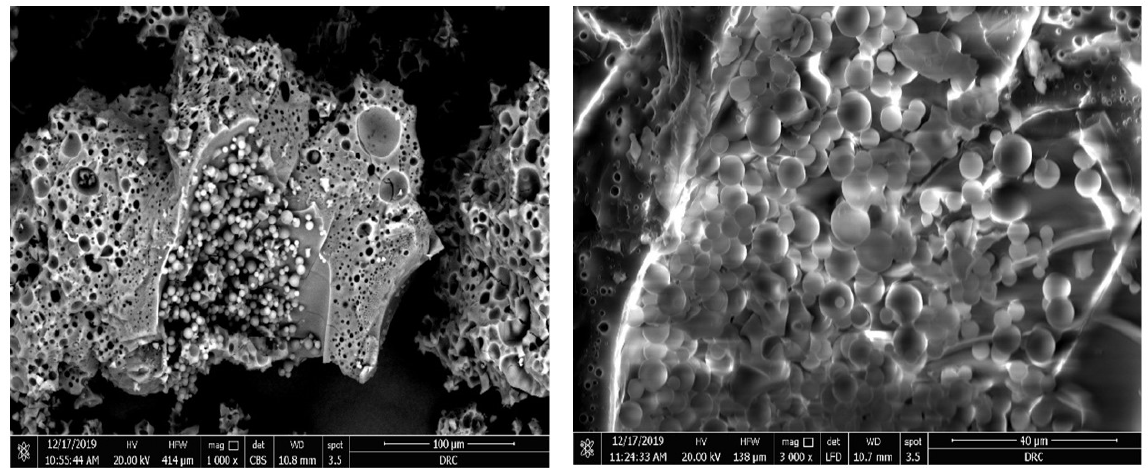
Figure 6. SEM Images for the SCM8–1 formulation showing the regular-shaped particles.